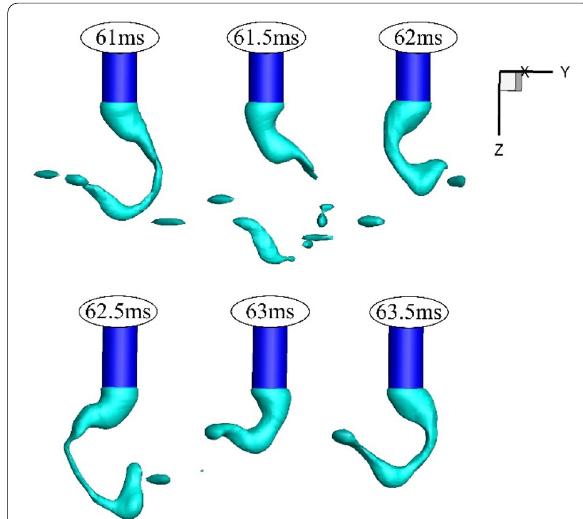
Figure 13 Metal transfer process of 500 A MIG without considering the arc